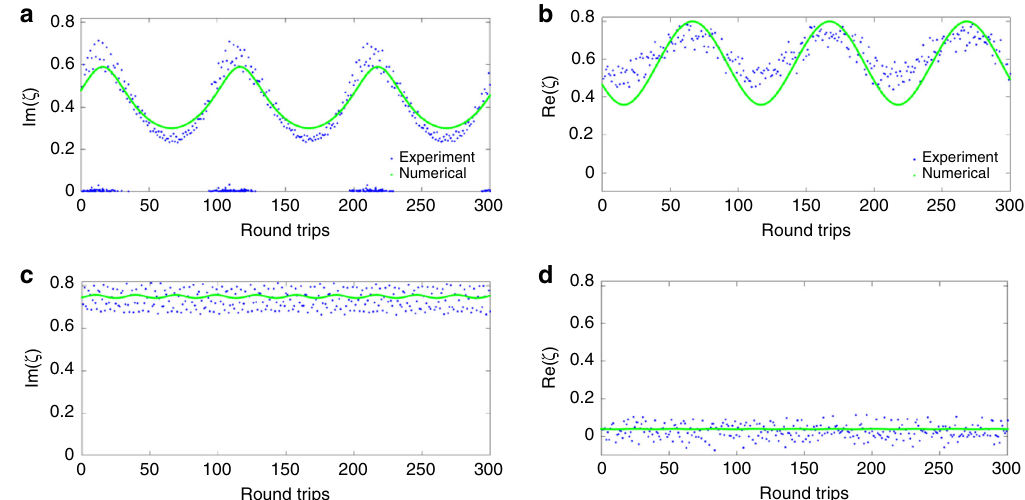
Fig. 4 Collective coordinate (CC) analysis of laser radiation. a The imaginary part, and b the real part of the discrete spectrum of the output of the laser when I 650 mA where the parameters of Eq. (8) are δ ¼ (cid:2) 0 : 2, a ¼ 0 : 0619, and K ¼ 0 : 0196. c The imaginary part, and d . the real part of the discrete p ¼ spectrum of the output of the laser when I 1200 mA where the parameters of Eq. (8) are δ ¼ (cid:2) 0 : 3, a ¼ 0 : 1, and K ¼ 0 : 2. These parameters obtained p ¼ through a CC analysis of the laser output, can be used to arrive at a channel model for the laser system under